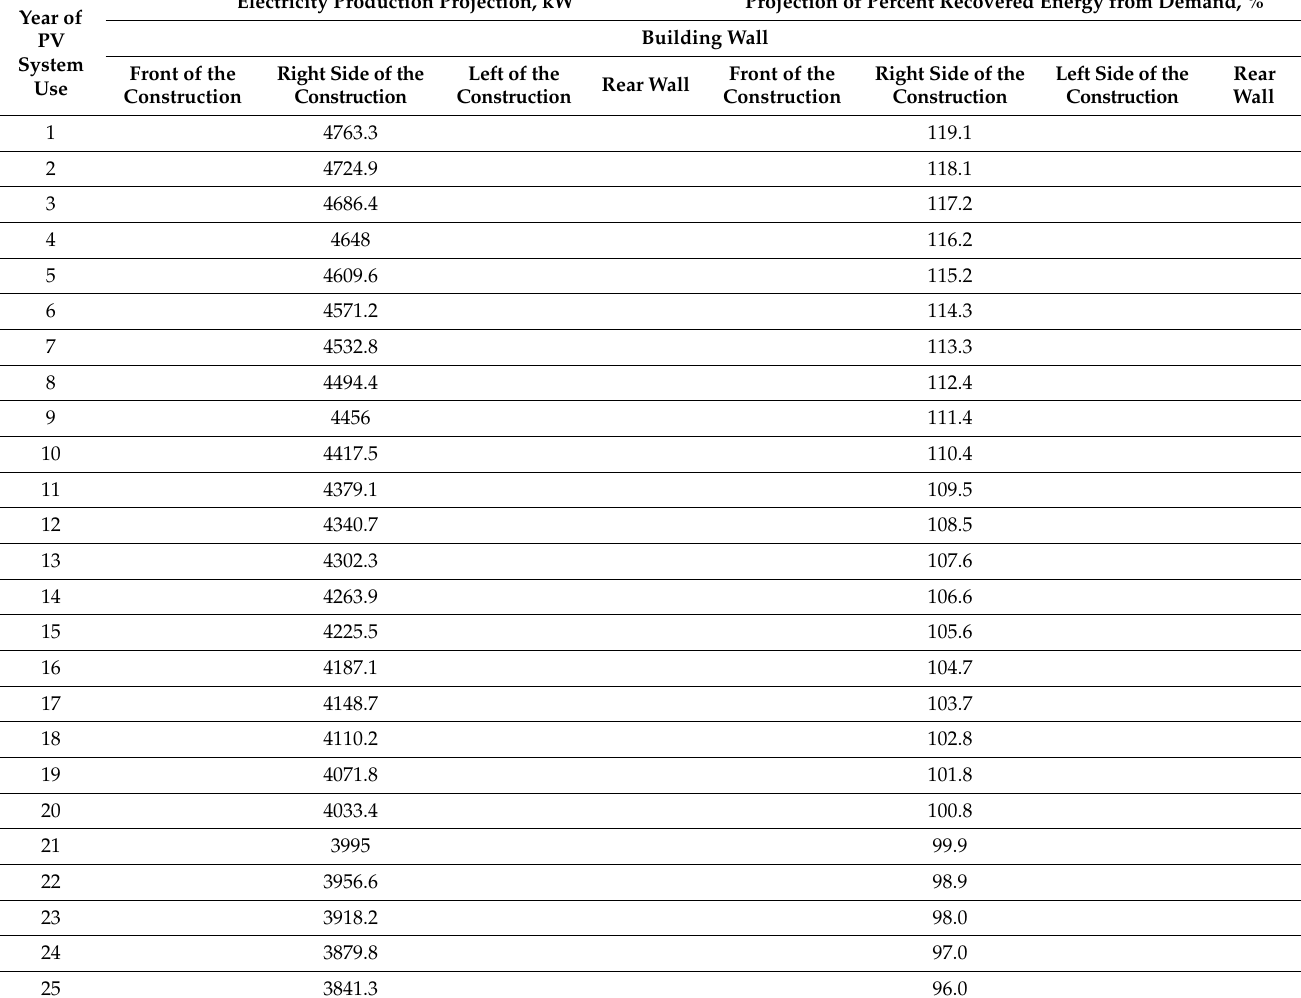
Table 13. Forecasting the electricity production of a photovoltaic system for a period of 25 years considering the PV degradation factor in kW and the percentage of recovered energy from energy